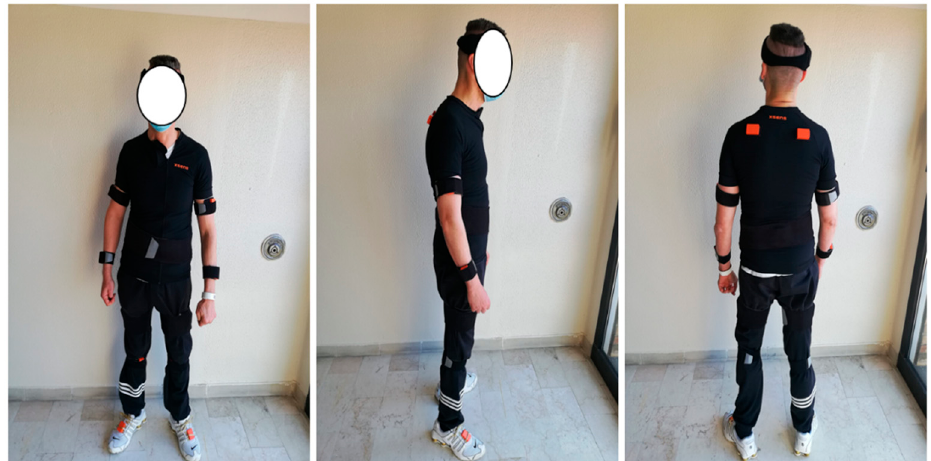
Figure 3. Sensors placement. Full-body placement of inertial sensor units for gait analysis in front view ( left ), side view ( middle ), and back view ( right ). Note: the sensors on the thigh were placed on the residual stump for the amputee leg and symmetrically on the sound limb, according to the manufacturer’s instruction.